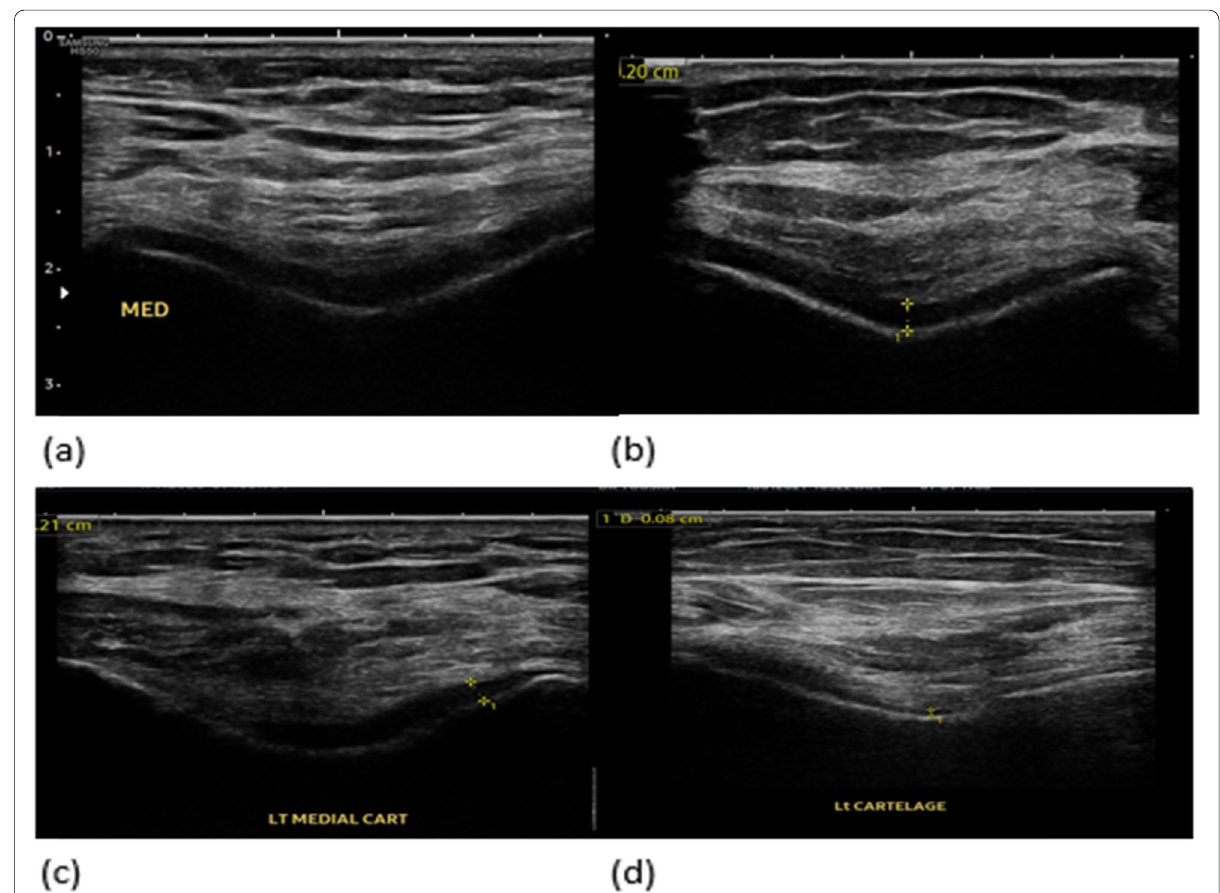
Fig. 2 Transversal scan of the femoral condyle for assessing the global femoral cartilage: a grade 1, b grade 2A, c grade 2B, and d grade 3. Multivariate linear stepwise regression analysis was performed to detect the most independent ultrasonographic variable predictor for WOMAC grading severity (Table 5, Fig. 3). Cartilage damage graded by GFC was the only independent predictor for WOMAC total score and WOMAC subscales; stiffness and physical function are relative to other ultrasonographic variables. WOMAC pain score was predicted only with the